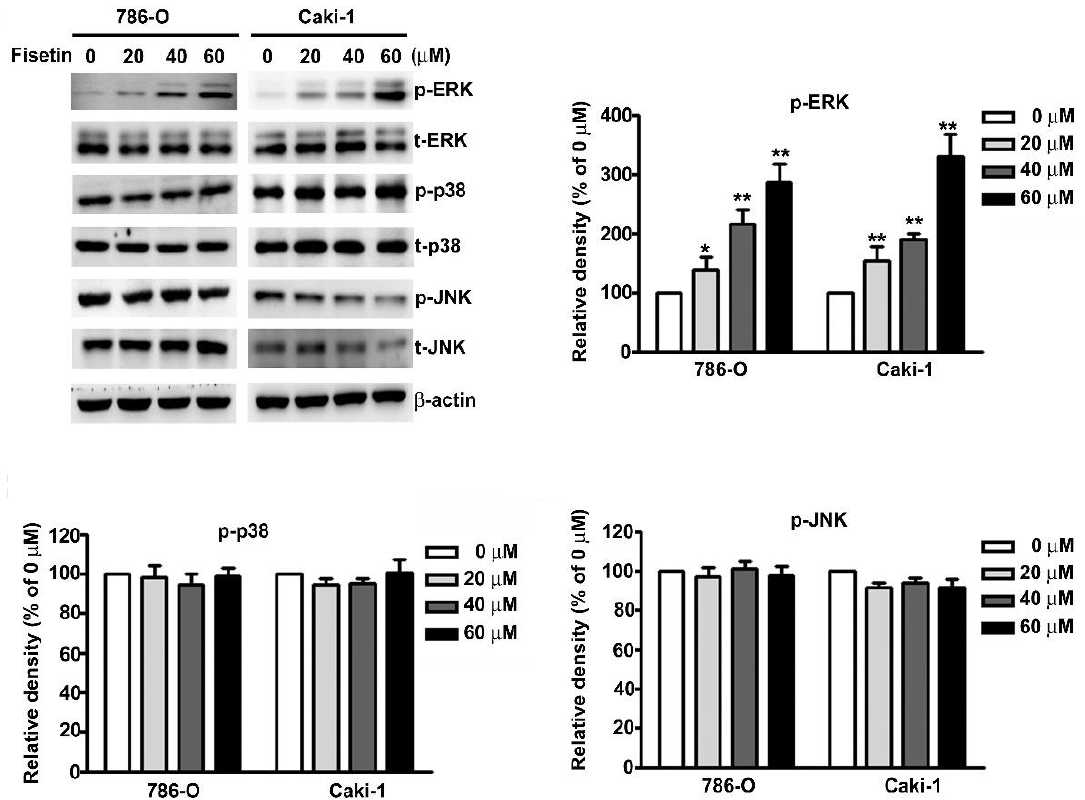
Figure 5. E ff ects of fisetin on the mitogen-activated protein kinase (MAPK) signaling pathway in RCC cell lines. 786-O and Caki-1 cells were incubated with various concentrations (0, 20, 40, and 60 µ M) of fisetin, and total cell lysates were then analyzed through Western blotting to determine the protein expression levels of p-ERK, t-ERK, p-p38, t-p38, p-JNK, and t-JNK. β -actin was used as an internal control for protein, with equal loading. Data are presented as the mean ± SE of at least three independent experiments. * p < 0.05, ** p < 0.01 compared with the untreated control (0 µ